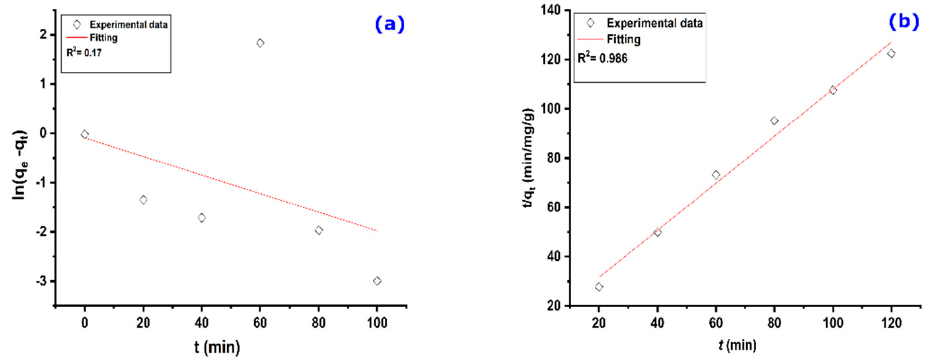
Figure 7. Kinetic models relating to adsorption of MO on AS: ( a ) pseudo-first order and ( b ) pseudo- second order. Experimental conditions: C 0 = 32.7 mg/g, m = 100 mg, V = 25 mL, T = 25 °C, pH = 6.